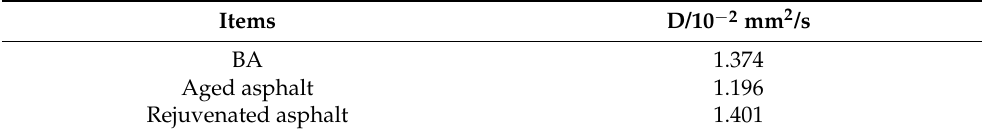
Table 4. Diffusion coefficient of asphalt.